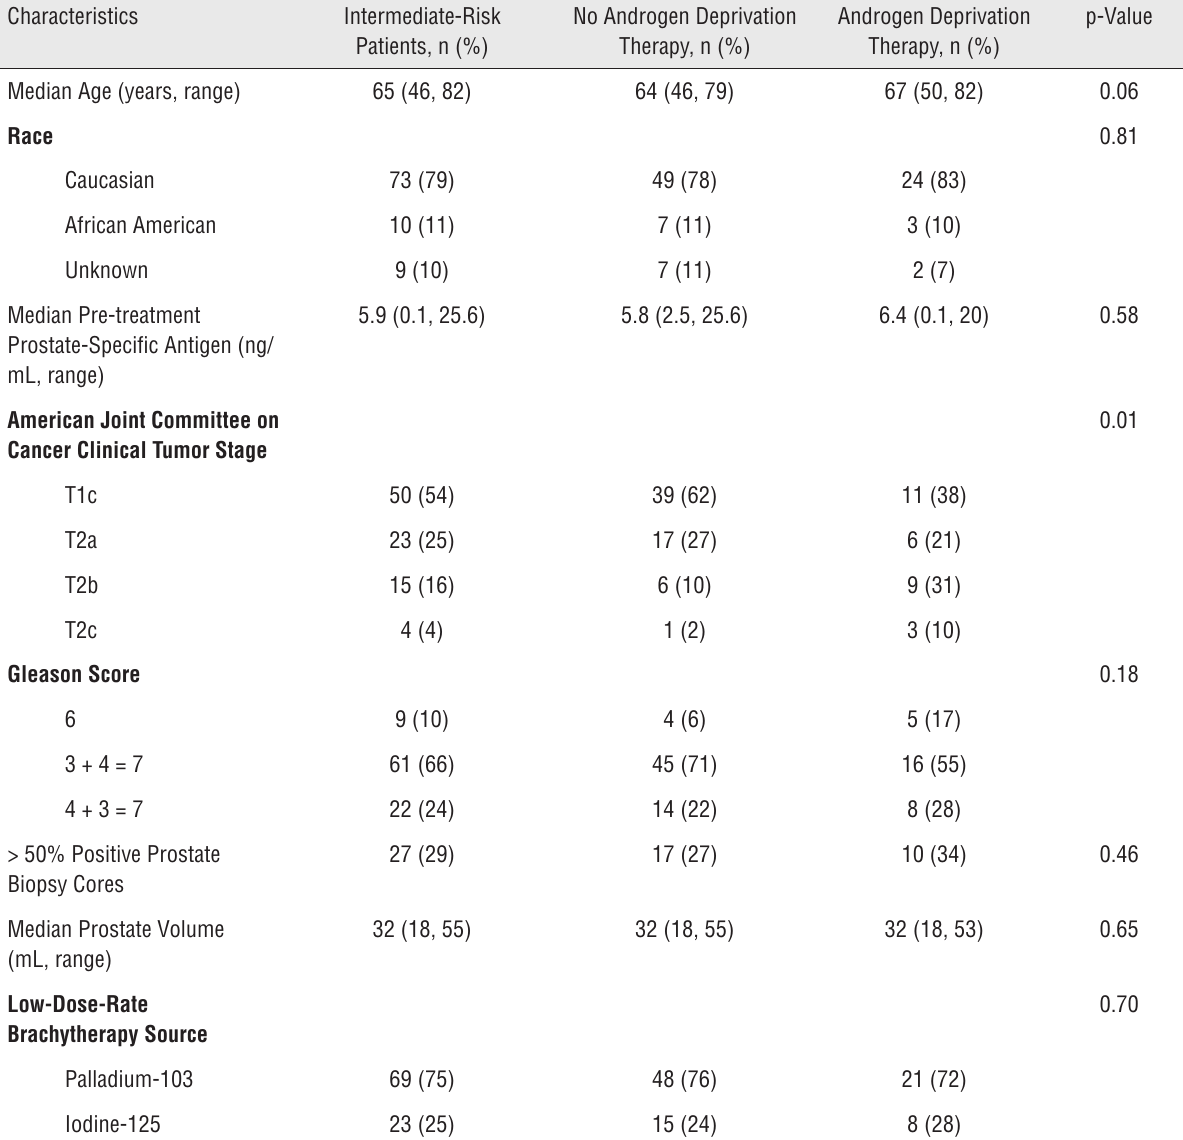
Table 2 - Characteristics of intermediate-risk prostate cancer patients who underwent EBRT and a LDR brachytherapy boost without (n = 63) or with (n = 29)